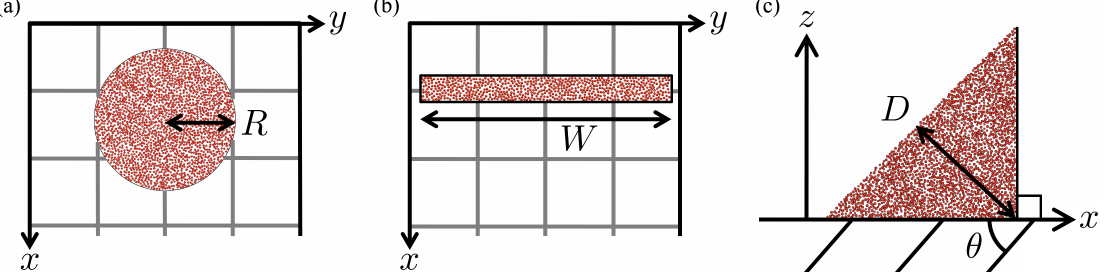
Figure 3. The three different types of initial conditions for particles in two-dimensional planes are as follows, ( a ) circle in the x – y plane, ( b ) rectangle in the x – y plane, and ( c ) triangle in the x – z plane. The x – y plane is parallel to the slope, whereas the x – z plane is the vertical cross section on the slope, where θ = 45 ◦ is the incline angle. In each initial condition, the circle radius R , rectangle width W , and triangle depth D are constant depending on the particle size, such that the particle volume fraction Φ p of 2000 particles is approximately